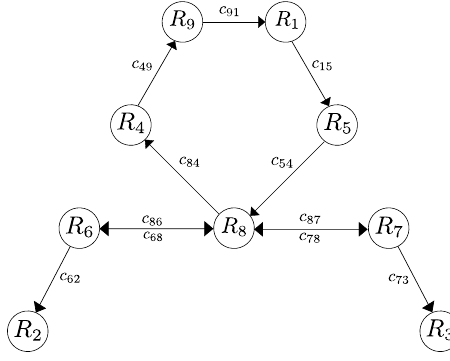
Figure 1. First desired formation.